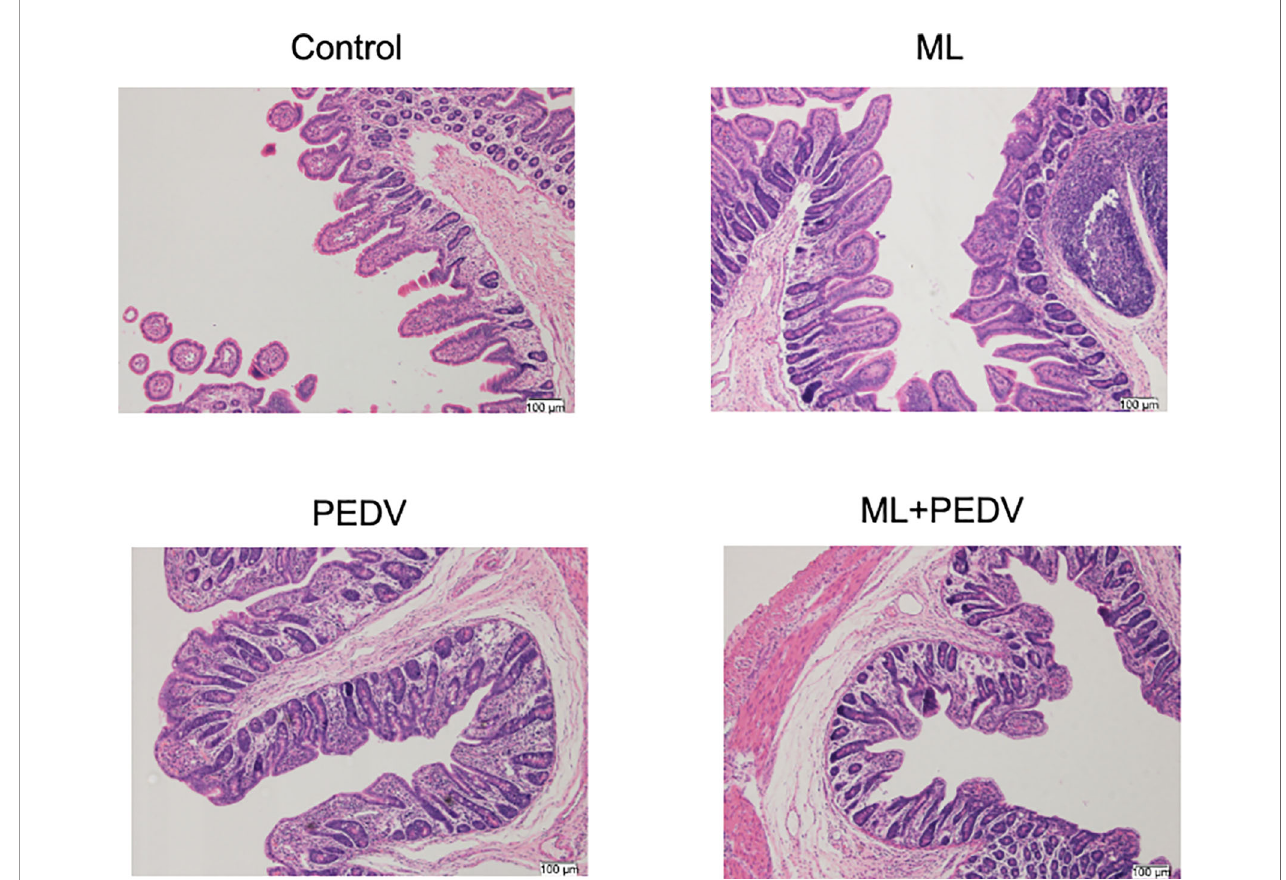
FIGURE 2 | Effects of ML administration on the ileum morphology in piglets infected with PEDV. (Hematoxylin and eosin staining,